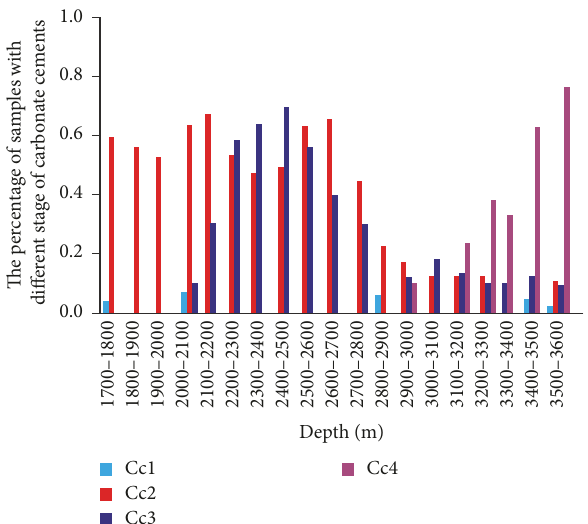
Figure 7: The distribution of carbonate cements with different morphological features in sandstone of Es in Dongying Sag.